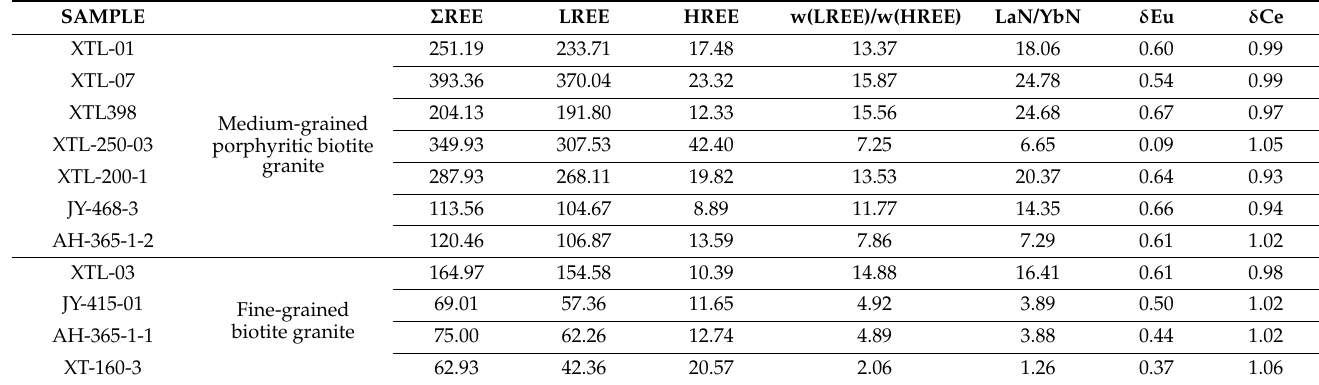
Table 4. Rare-earth element characteristics in granite in Xintianling ore field, Hunan.